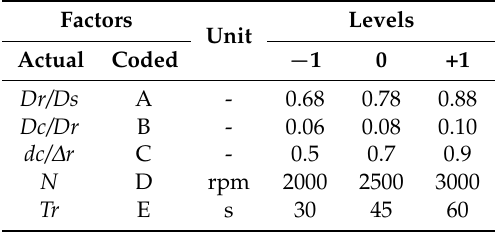
Table 2. Experimental ranges and levels of the independent variables for RSM